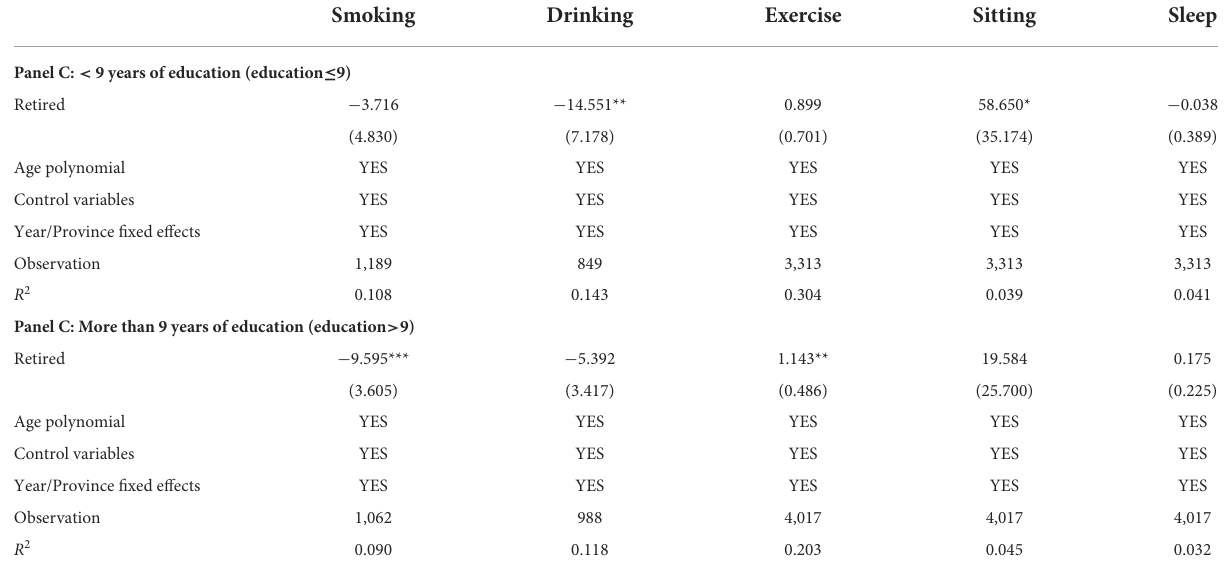
TABLE 5 Heterogeneity by education.